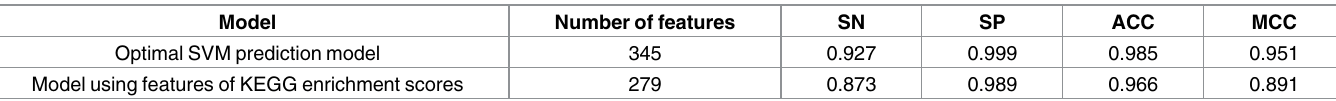
Table 1. The SN , SP , ACC , and MCC yielded by the optimal SVM prediction model and the model using featuresof KEGG enrichment scores. Model